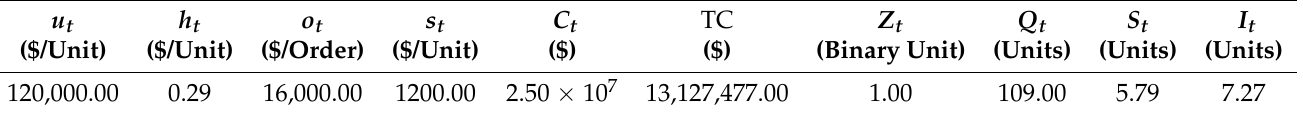
Figure 3. Histogram ( left ) and ECDF ( center ) with the respective fitted WEI3 PDF and CDF; and QQ plot ( right ) for the WEI3 distribution with monthly drug DPUT data. Table 14. Coefficients to carry out the two-stage SP in case study with monthly drug DPUT